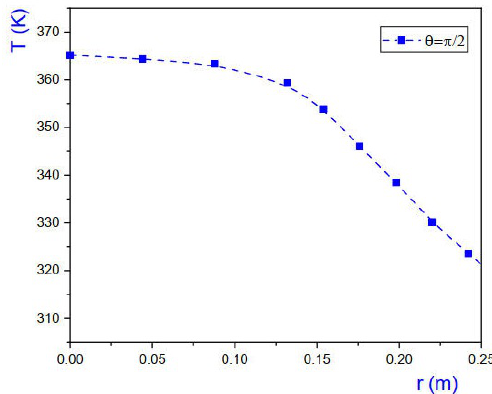
Figure 13. Temperature distribution along r ( θ = π /2 ) . The distribution was obtained from the thermography shown in Figure 11d. Note that, in the steam chamber, the temperature changes slowly, but outside the chamber edge, located at r = R c = 0.157 m, the temperature changes in a rapid